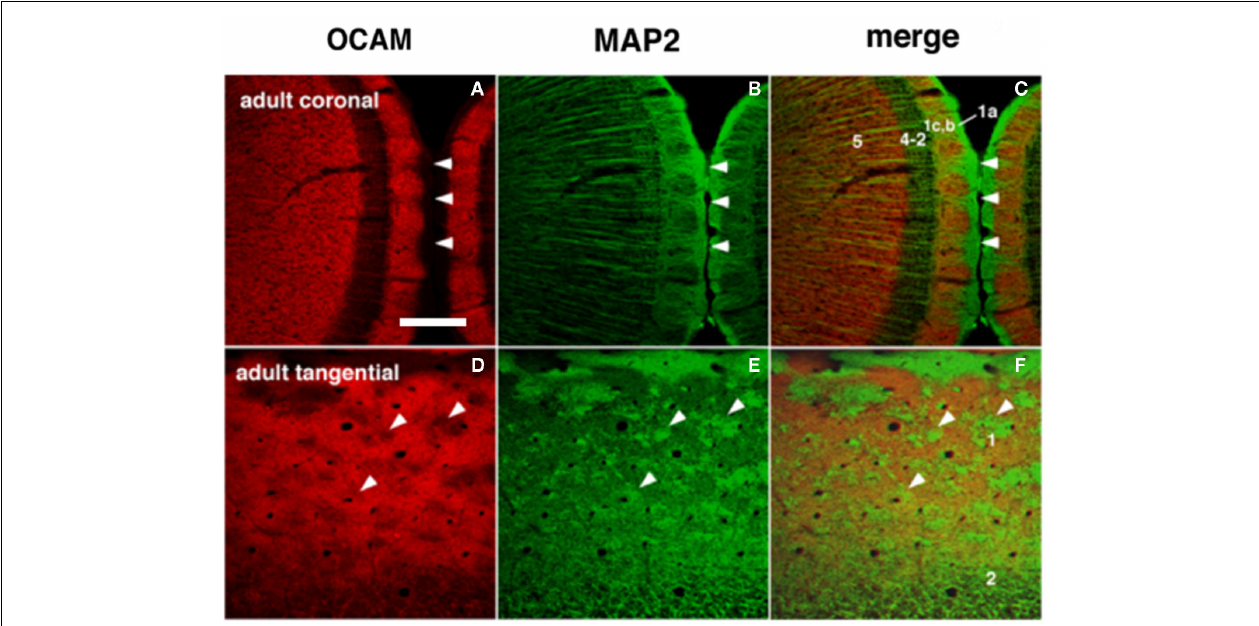
interdigitate. (A–C) Coronal sections. (D–F) Semi-tangential sections. Arrowheads point to corresponding locations in two sets consisting of three figures (A–F) . Arabic numbers indicate layers. Scale bar: 200 μ m.